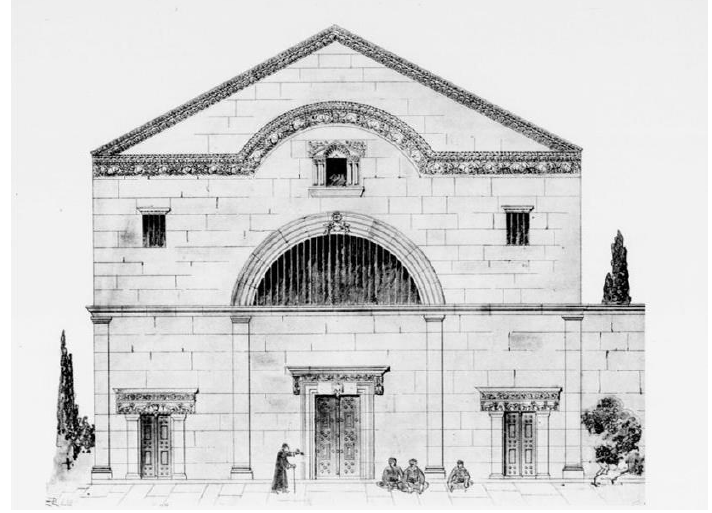
Figure 8. Synagogue in Capernaum (Tell Humm, Kfar Nahum), theoretical reconstruction by (Kohl and Watzinger 1916, plate 3).